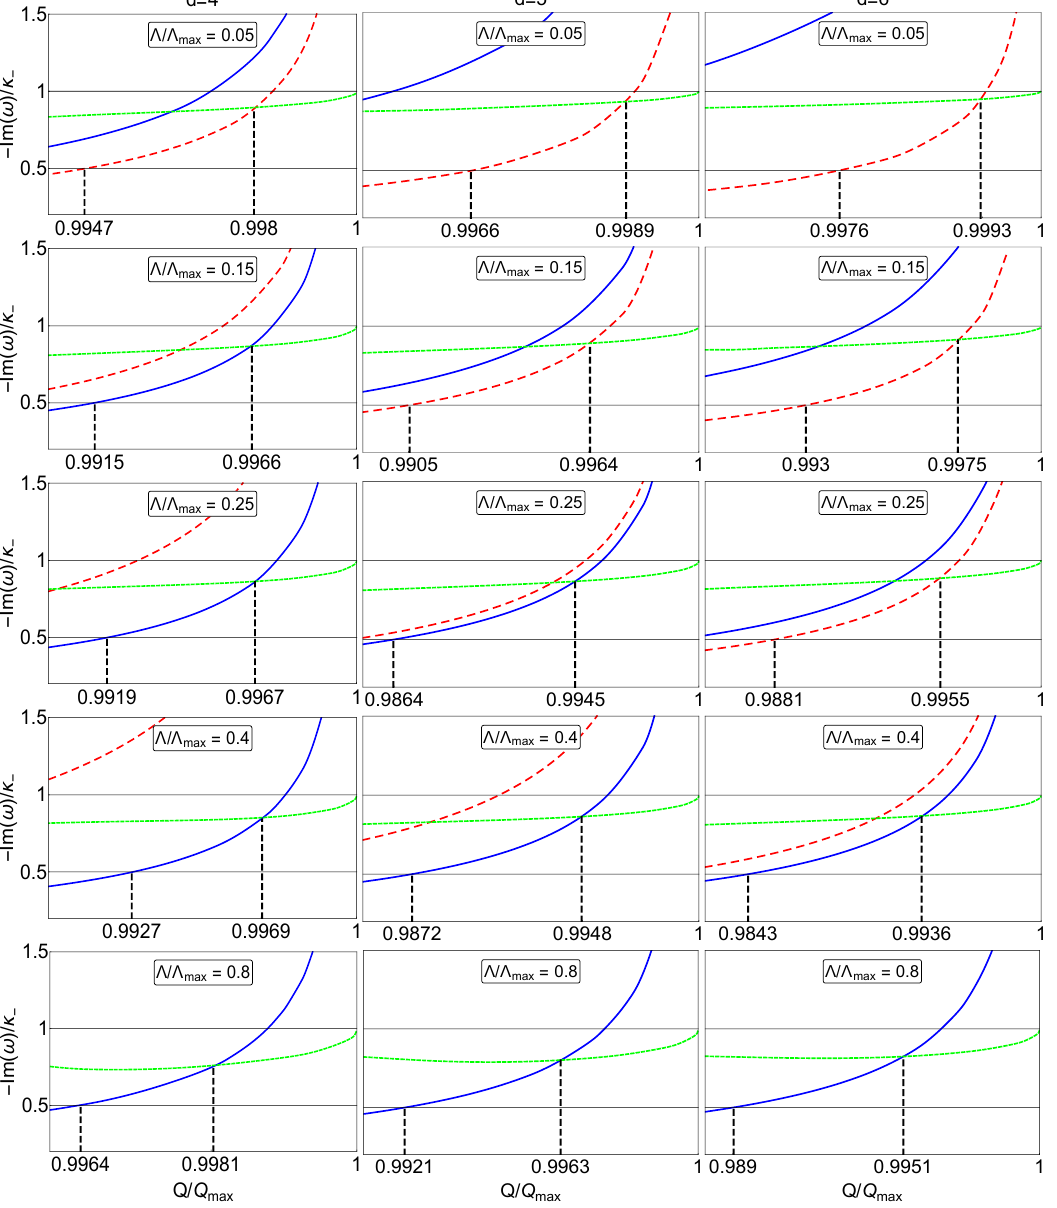
Figure 1 . Dominant modes of di(cid:11)erent families, showing the (nearly) dominant complex PS mode (blue, solid) at l = 10, the dominant BH dS mode (red, dashed) at l = 1 and the dominant NE mode (green, dashed) at l = 0 for d = 4 ; 5 and 6-dimensional RNdS spacetime with M = 1. The two dashed vertical lines designate the points where (cid:12) = (cid:0) Im( ! ) =(cid:20) (cid:0) = 1 = 2 and where the NE mode becomes dominant. The dS family in the (cid:12)nal row of plots is too subdominant, thus lying outside of the region of